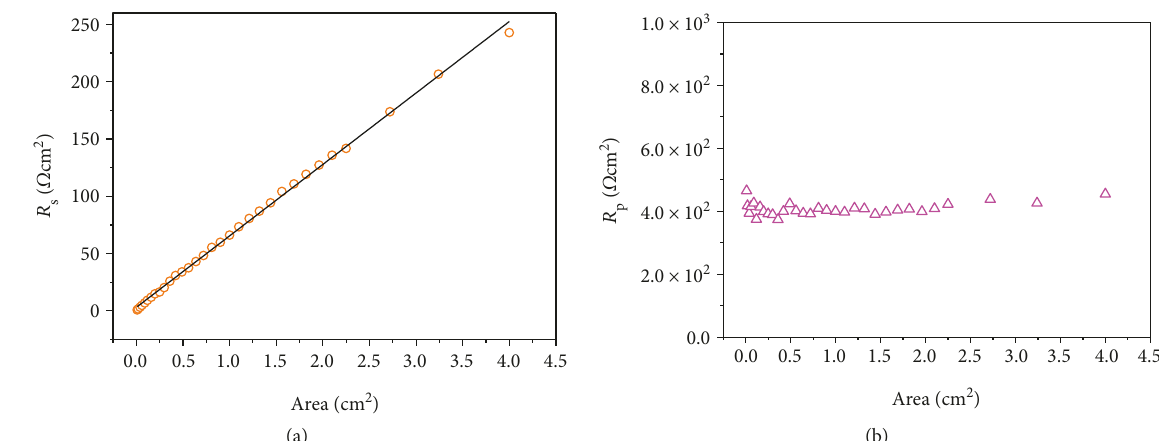
Figure 5: (a) Device series resistance value related to the active area. A linear relationship between R parallel resistance was kept almost constant with active area increase.